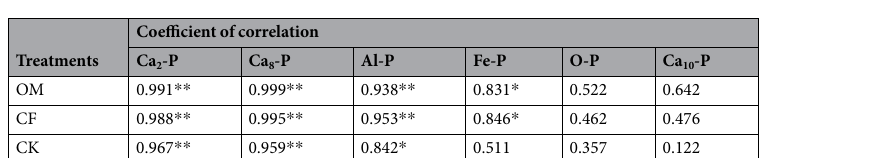
Figure 2. Changes in different Pi fractions over time under different treatments during the experimental period.